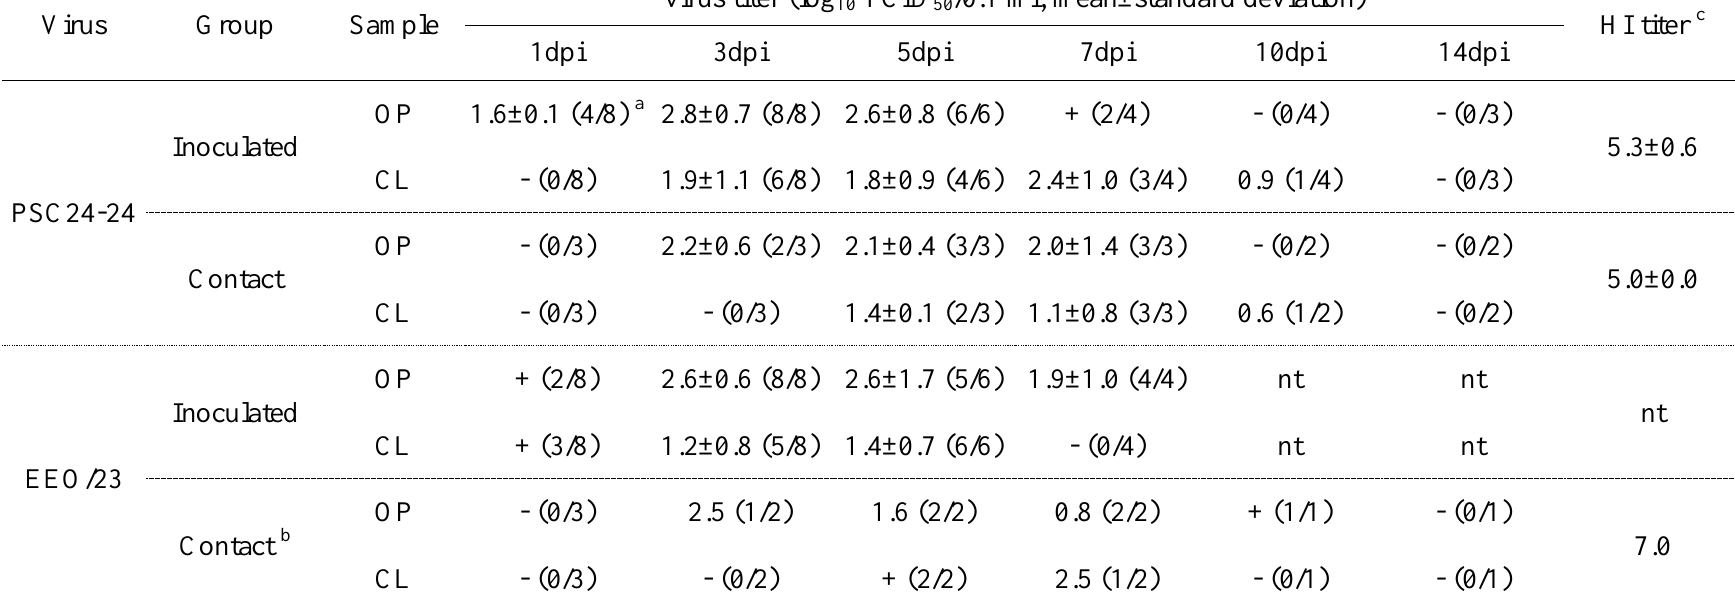
Table 3. Virus re-isolation with swab samples from experimentally inoculated ducks. Eight ducks were inoculated intranasally with 10 6.0 EID /0.1 ml of A/mandarin duck/Korea/PSC24-24/2010 (PSC24-24) and A/Eurasian eagle owl/Korea/23/2010 (EEO/23), and 3 ducks were 50 co-housed with the infected ducks as a contact group. Oropharyngeal and cloacal swab samples were collected on the indicated day, and the virus was titrated in CEF. Virus titer is the average of the calculable positive samples. The detection limit of the CEF cell culture was set to 10 0.6 TCID /0.1 50